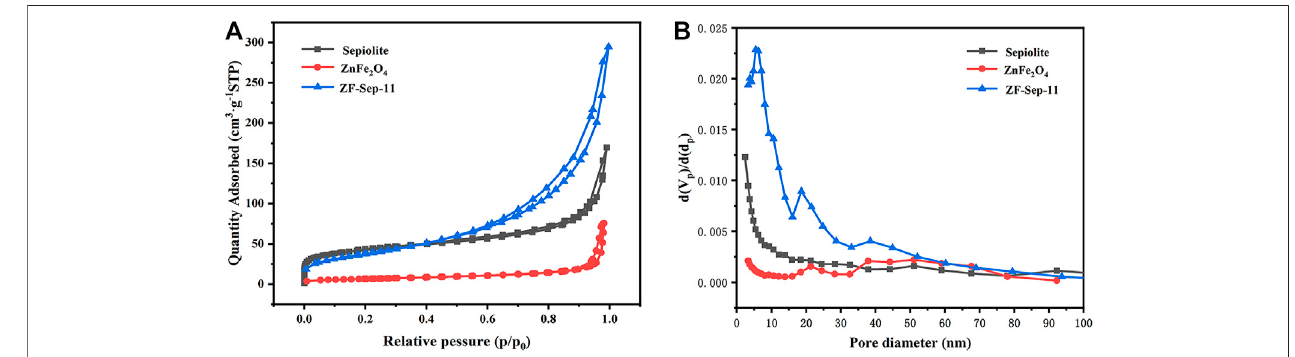
FIGURE 6 | (A) The N 2 adsorption-desorption isotherms, and (B) pore size distribution of sepiolite, ZnFe 2 O 4 and ZF-Sep-11.